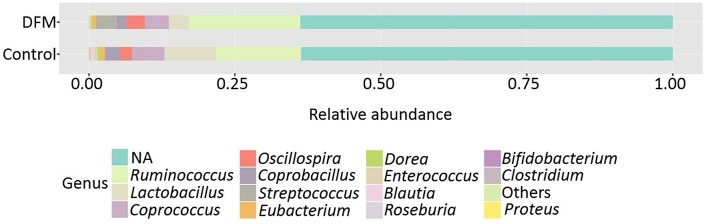
Relative abundance of major genera recovered in ceca of broiler chickens at day 10 from two different treatment groups (control and DFM). NA refers to those reads that could not be assigned to any genera. Genera having counts <100 are merged together in “Others”.